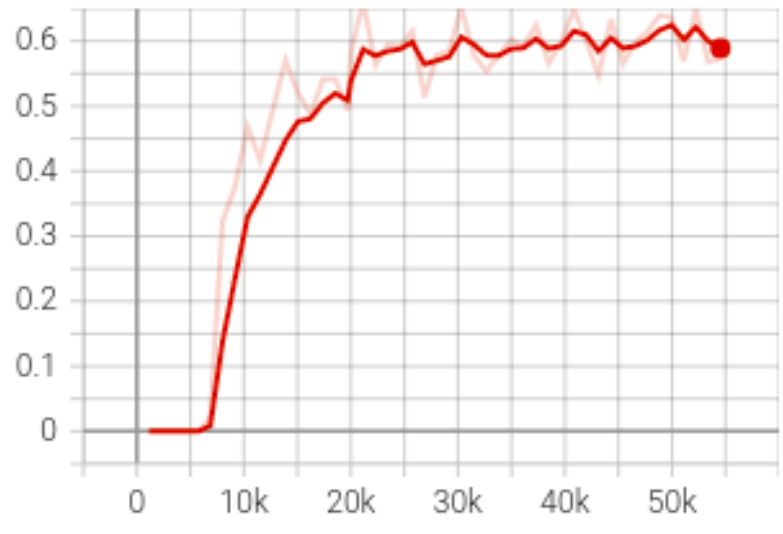
Figure 16. mAP accuracy for SSD model.